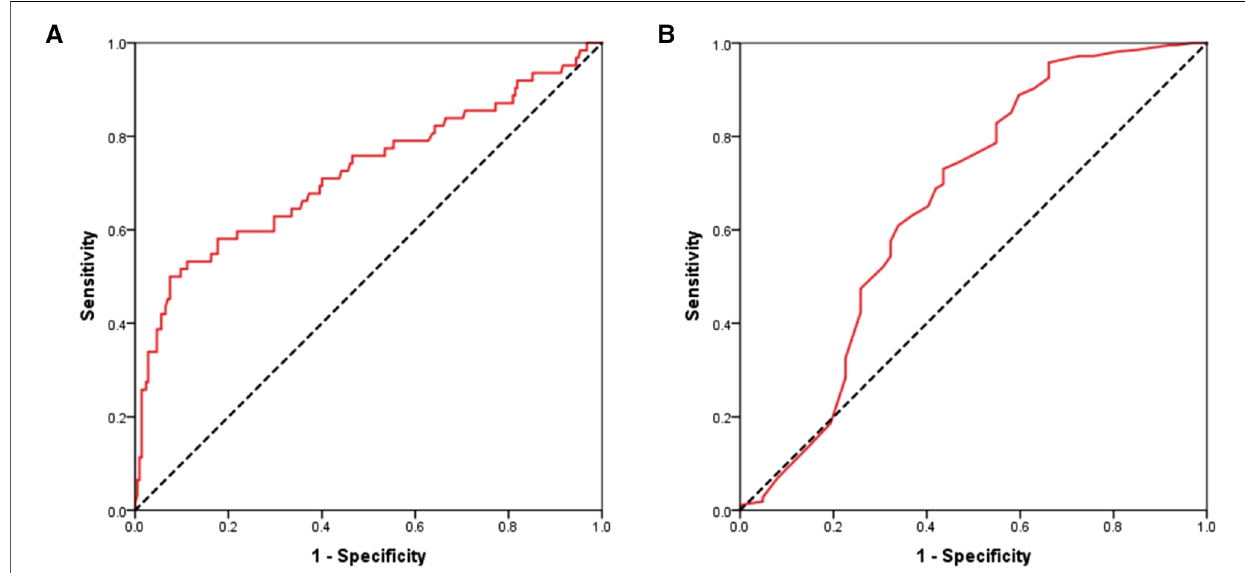
FIGURE 3 Receiver operating characteristic curves of circulating IGFBP-2 ( A ) and EF ( B ) for predicting MACEs in patients with ACS. IGFBP-2, Insulin like growth factor binding protein 2; EF, Ejection fraction; MACEs, Major adverse cardiovascular events; ACS, Acute coronary